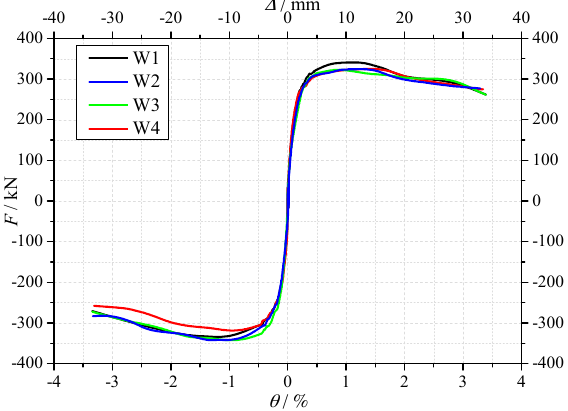
Figure 10. The skeleton curves of the specimens W1–W4.